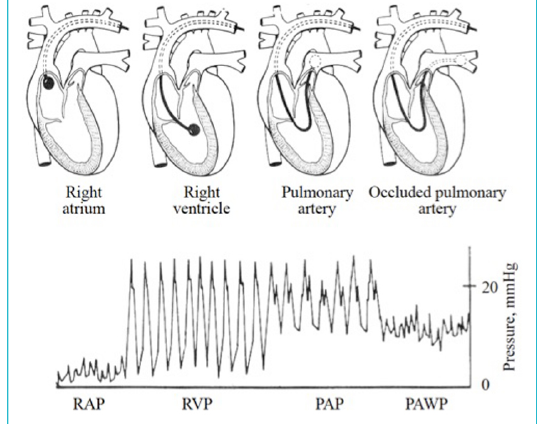
Figure 2: Haemodynamic pressure tracings obtained during the insertion of a pulmonary artery catheter. Right atrial pressure (RAP) and pulmonary artery wedge pressure (PAWP) share similar morphology. The transition from the right ventricle to the pul- monary artery is characterized by an increase in diastolic pressure and by the appearance of a dicrotic notch, which reflects the pul- monic valve’s closure. RVP = right ventricular pressure. Open ac- cess figure from